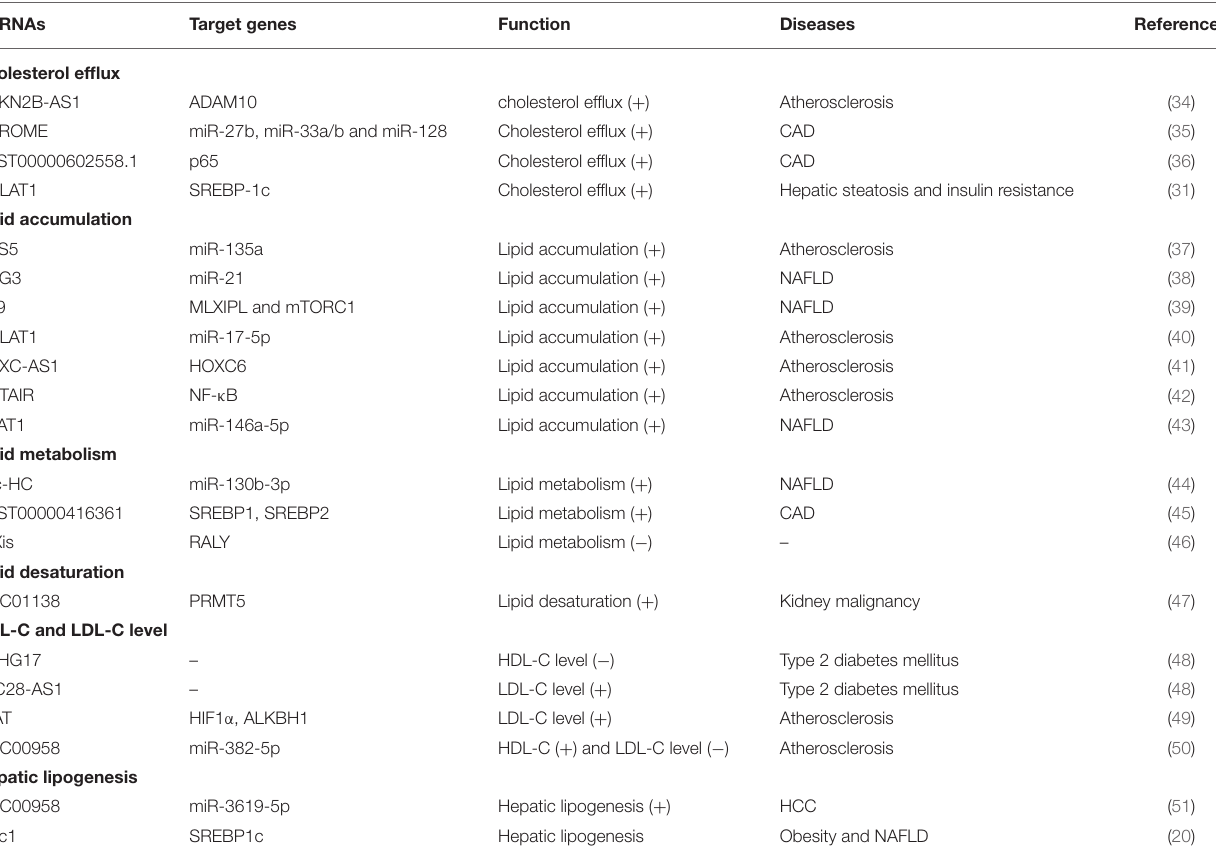
TABLE 1 | Summary of lncRNAs diseases with disturbed cholesterol homeostasis.